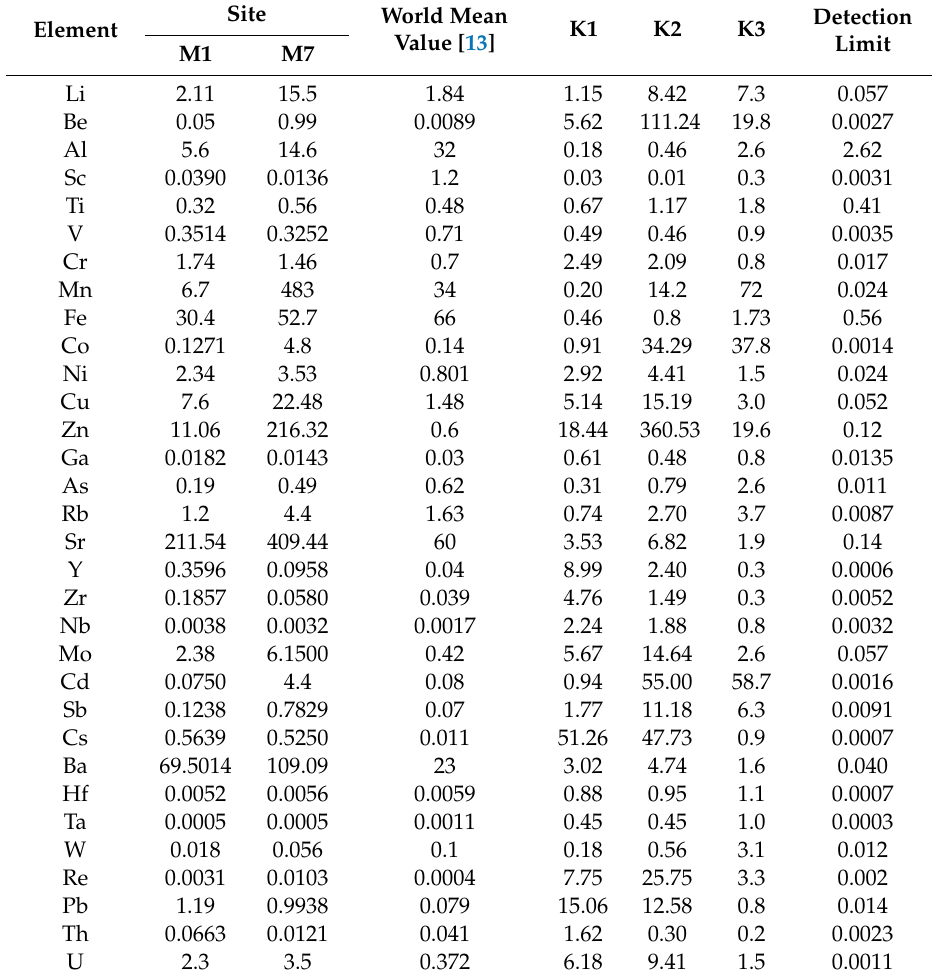
Table 3. The mean value trace-elements concentrations of the river Modonkul at the sites M1 and M7 ( n = 15—number of samples) ( µ g · L − 1